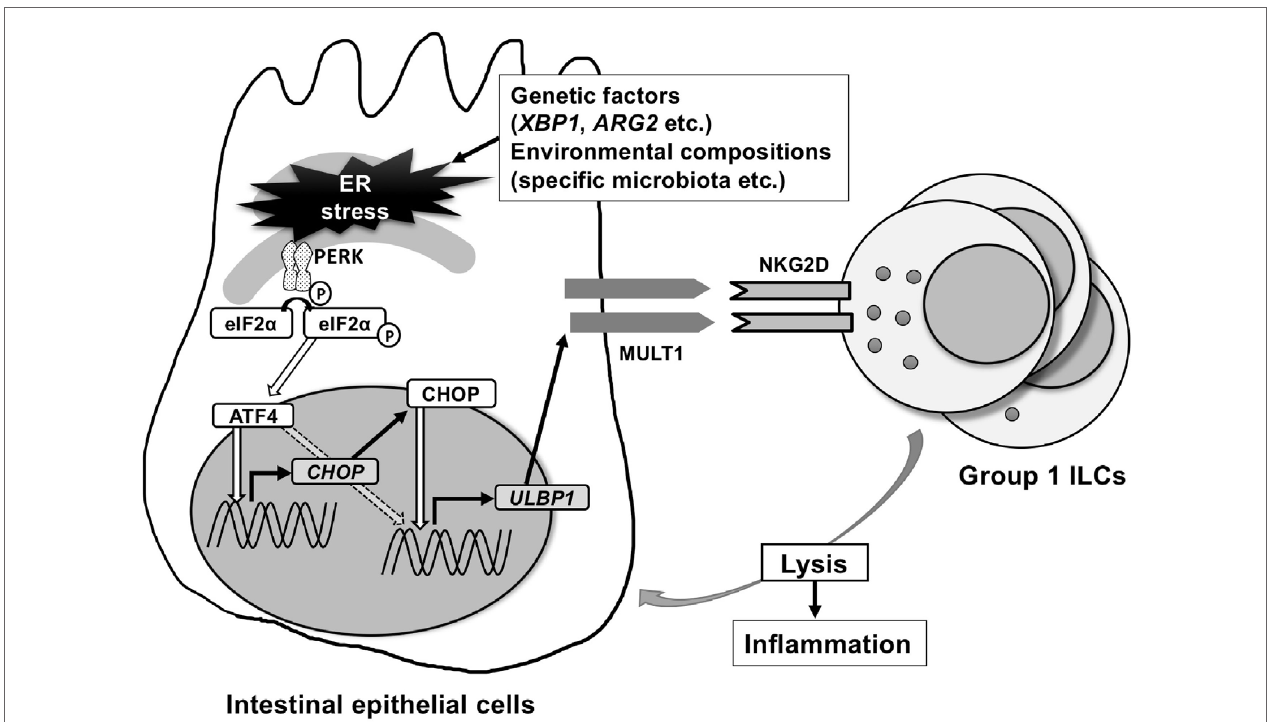
FiGURe 1 | Endoplasmic reticulum (ER) stress-inducing murine UL16-binding protein like transcript 1 (MULT1) in mouse. MULT1 [encoded by UL16 binding protein 1 ( Ulbp1 )], but not other natural-killer group 2 member D (NKG2D)-ligands, mRNA, and surface expression are upregulated on ER-stressed mouse small intestinal epithelial cells. This occurs through activating factor 4 (ATF4) and/or C/EBP homologous protein (CHOP) presumably downstream of the protein kinase RNA-like ER kinase pathway. CHOP as a transcription factor binds directly to the promoter area of Ulbp1 , which upon expression subsequently activates NKG2D-expressing intraepithelial group 1 innate lymphoid cells (ILCs) [natural killer (NK) cells and ILC1] that accumulate within the intestinal epithelium and promote small intestinal